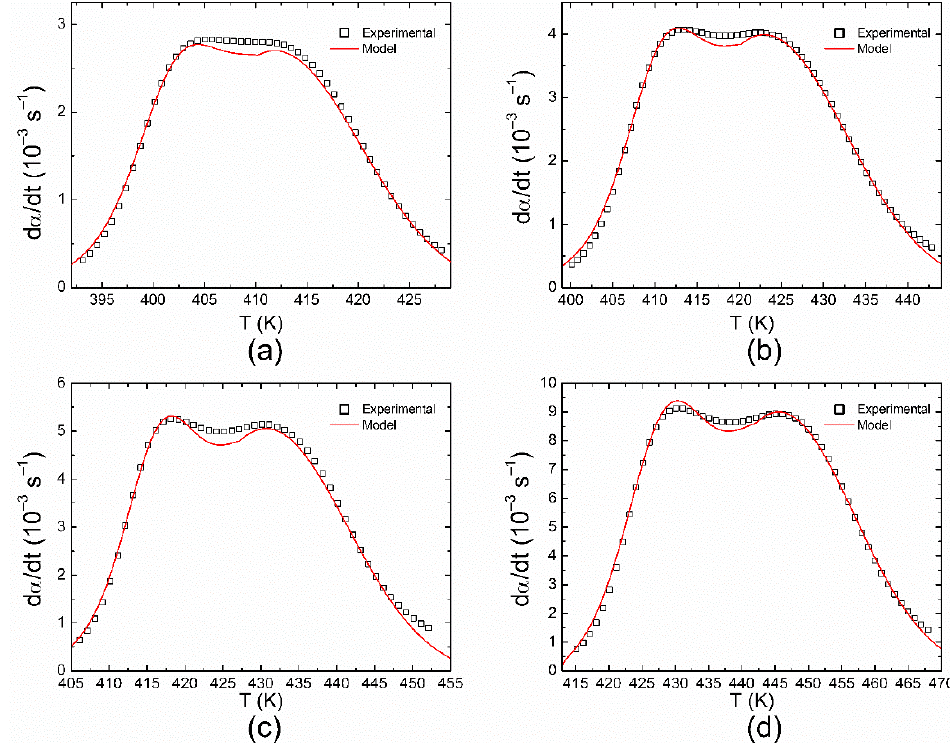
Figure 9. Conversion rate as a function of temperature at different heating rates: ( a ) 4; ( b ) 7; ( c ) 10; and ( d ) 20 °C/min.